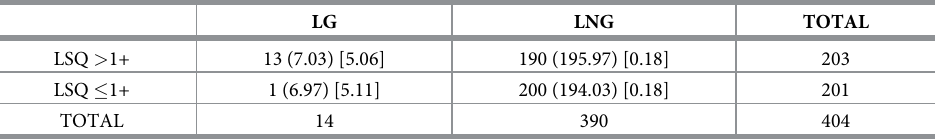
Table 2. Distribution of individuals between groups according to the number of responses marked given to the LSQ greater than or less than 1 (Table 2 x 2).